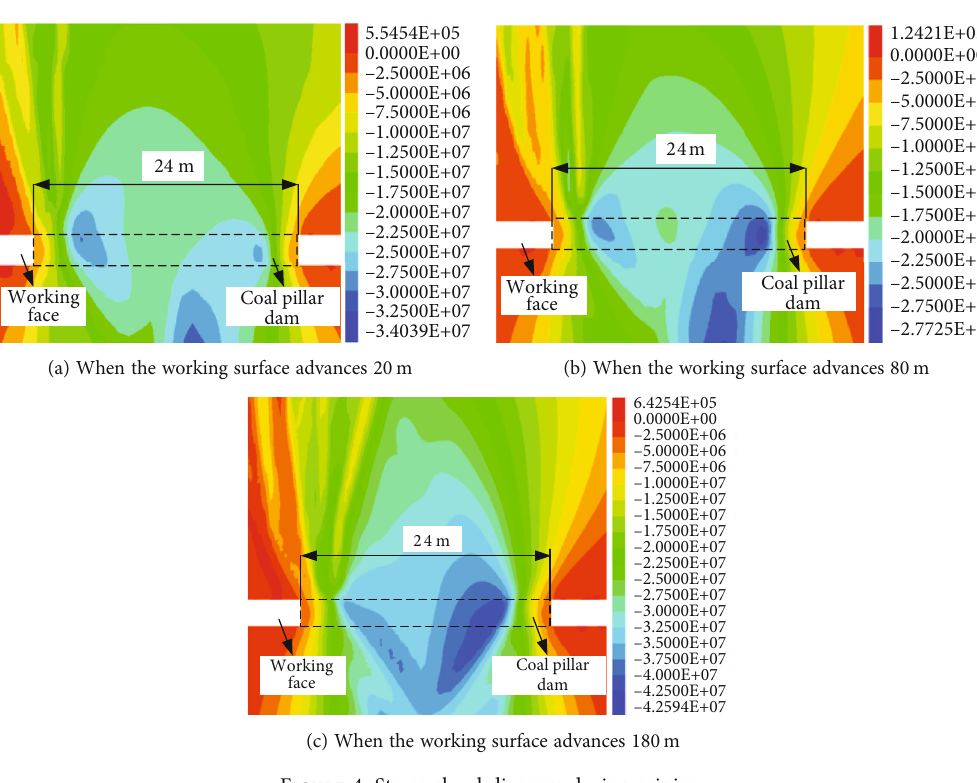
Figure 4: Stress cloud diagram during mining.